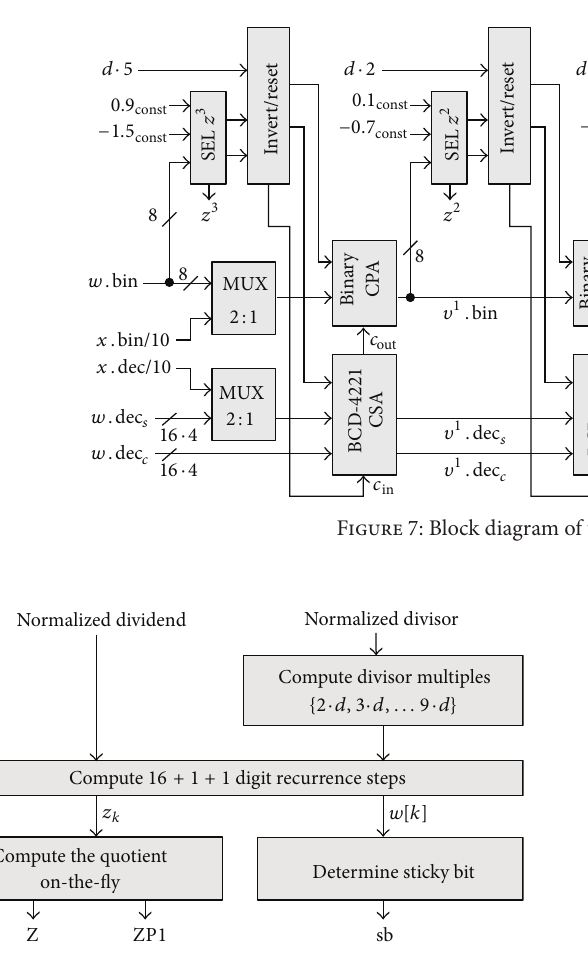
Figure 8: Block diagram of the normalized type1 division.